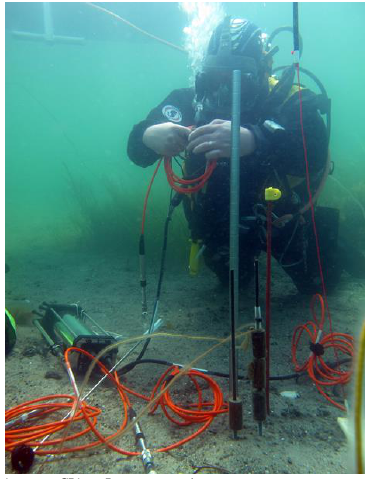
Figure 4 In situ profiling logger and spear